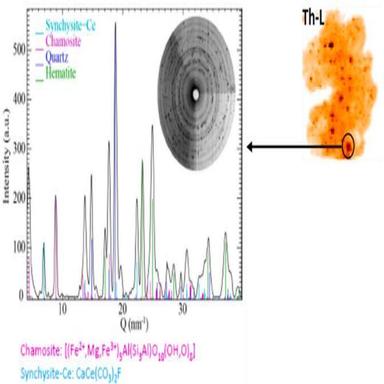
Results from μ-XRD point measurement in a Th-rich hotspot of a soil particle from the Fen site. The diffractogram (left) was recorded from a hotspot location, indicated by a black circle (right), selected on the basis of the thorium